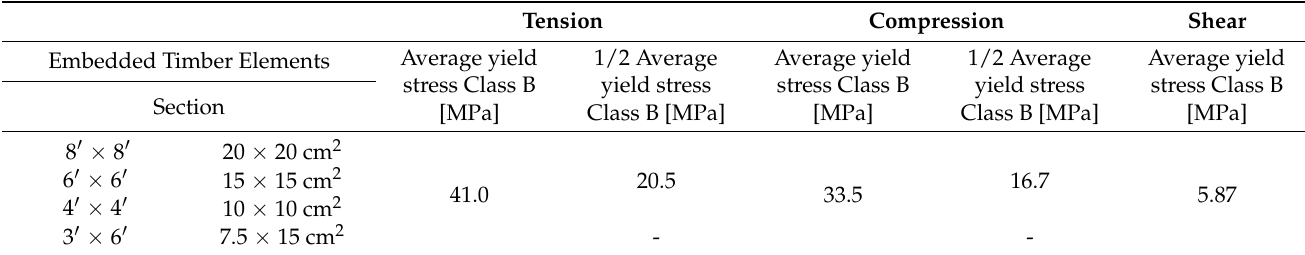
Table 2. Average and reduced values of strength in timber strengthening elements, with tie beams at free spans excluded.